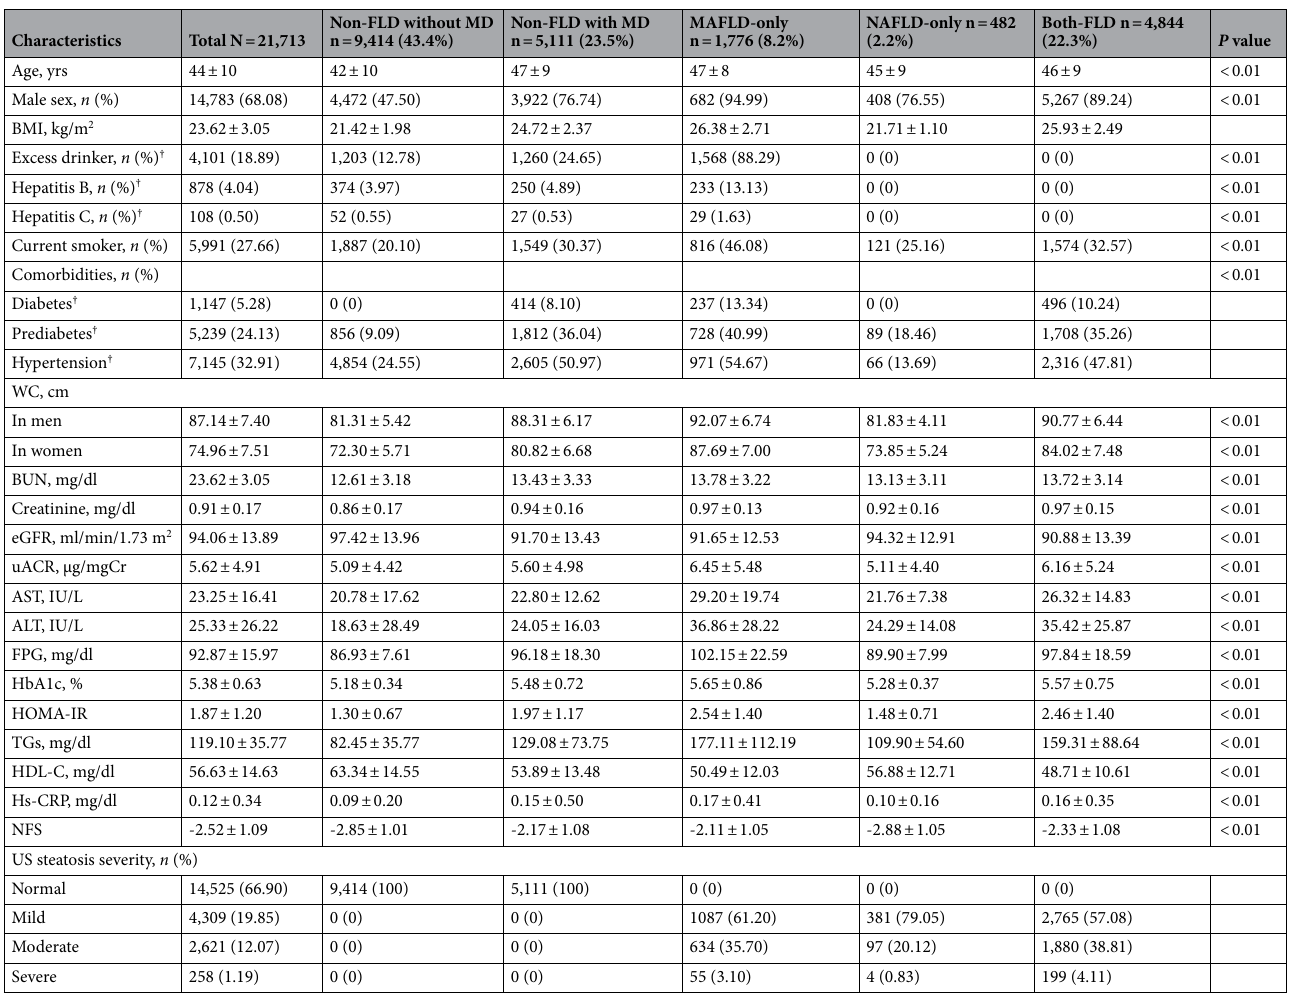
Table 1. Comparison of baseline characteristics in subjects. Data are shown as mean ± standard deviations or frequency as appropriate. P-value was calculated using One-way ANOVA test for continuous variables and Chi-square test for categorical variables. The Scheffe test was used in post-hoc analysis. ALT alanine aminotransferase, AST aspartate aminotransferase, BMI body mass index, DBP diastolic blood pressure,